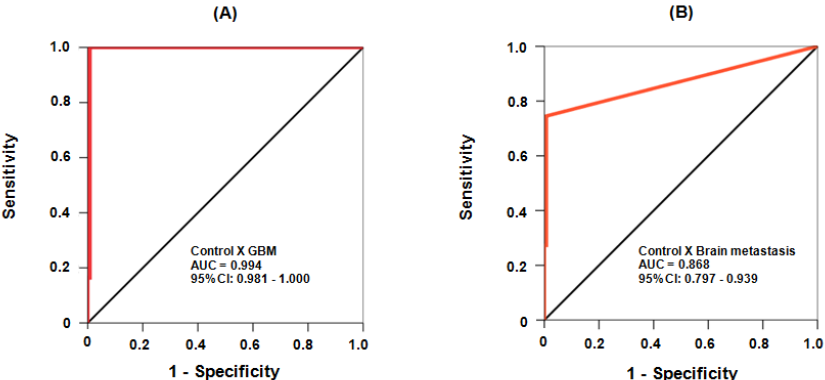
Figure 2. Receiver operating characteristic (ROC) analysis of sensitivity and specificity of cfDNA serum levels for distinguishing healthy control from those with GBM ( A ) and brain metastasis ( B ). The black diagonal line defines a test with no discriminative power (it is, random chance result with zero diagnostic capability, equivalent to an area under the curve (AUC) = 0.5); the red line represents accuracy and increasing diagnostic power the more distant its plot is located from the diagonal black line.